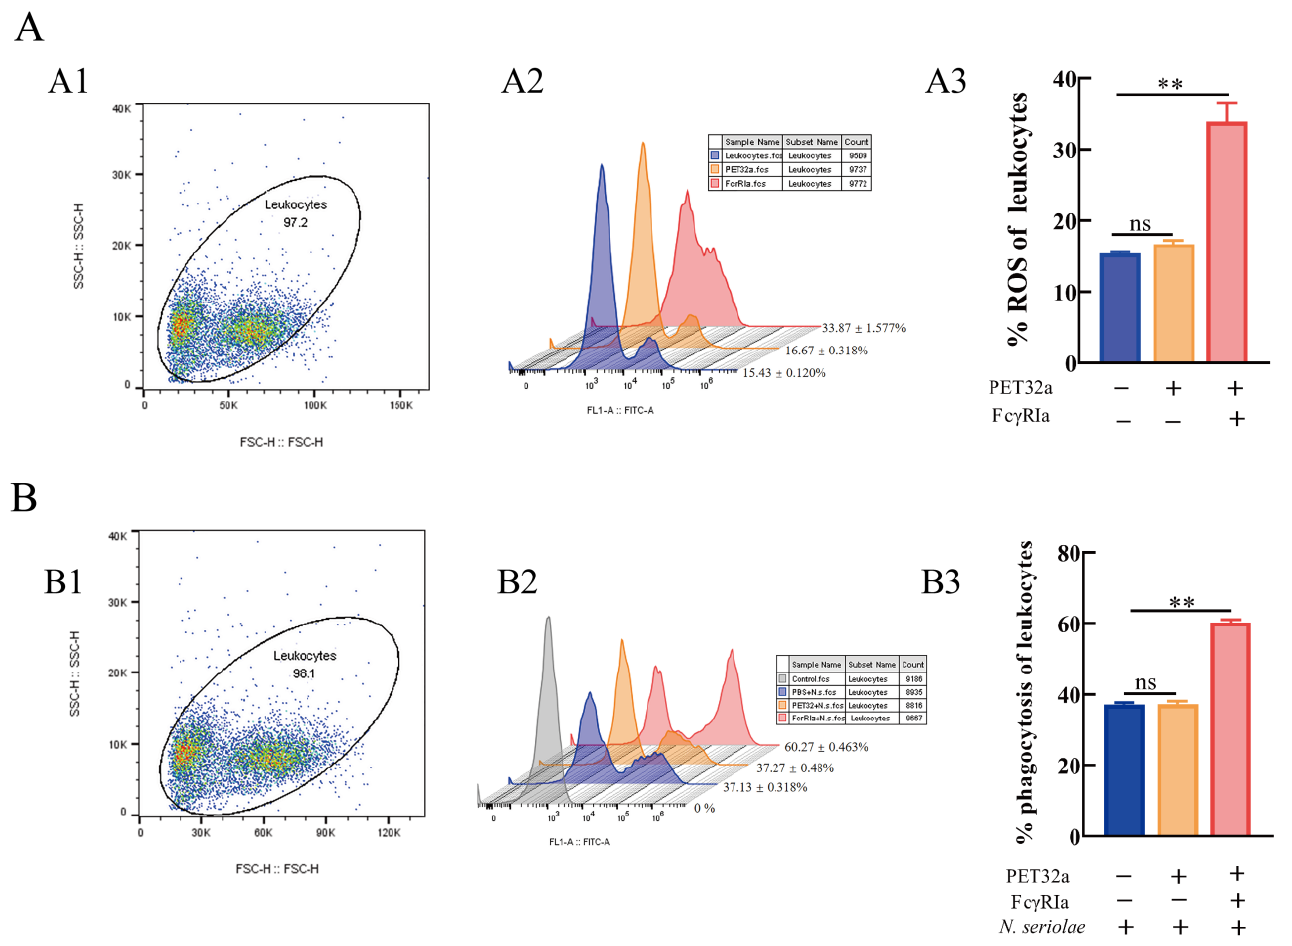
Figure 9. Effects of (r)MsFc γ RI α on ROS ( A ) and phagocytosis to N. seriolae ( B ) of largemouth bass leukocytes by flow cytometric. ( A1 / B1 ): FSC/SSC plots leukocytes; ( A2 / B2 ): The histogram of flow cytometric analysis of the leukocytes ROS/phagocytosis pre-incubated with PBS, pET-32a protein or recombinant MsFc γ RI α (5 µg/mL). The results shown here were one of three independent experiments; ( A3 / B3 ): The histogram of the ROS/phagocytosis rates. Three biological replicates were performed, and the data are presented as mean ± SEM ( n = 3). p > 0.05, not significant (ns); significant; p < 0.01 (**), extremely significant.